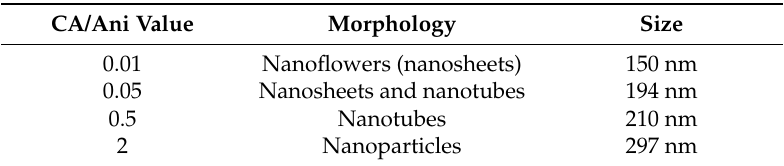
Figure 5. SEM images of the PANI samples synthesized with CA/Ani = ( a ) 0.01, ( b , c ) 0.1, ( d ) 0.5, ( e ) 2, and ( f ) the morphologies of the PANI at 4 h. The others reaction conditions: APS/Ani = 1, in ice bath for 24 h. Table 1. Effect of molar ratio of CA/Ani on the morphology of the products with the synthesis conditions: ice bath, certain amount of Ani and APS.